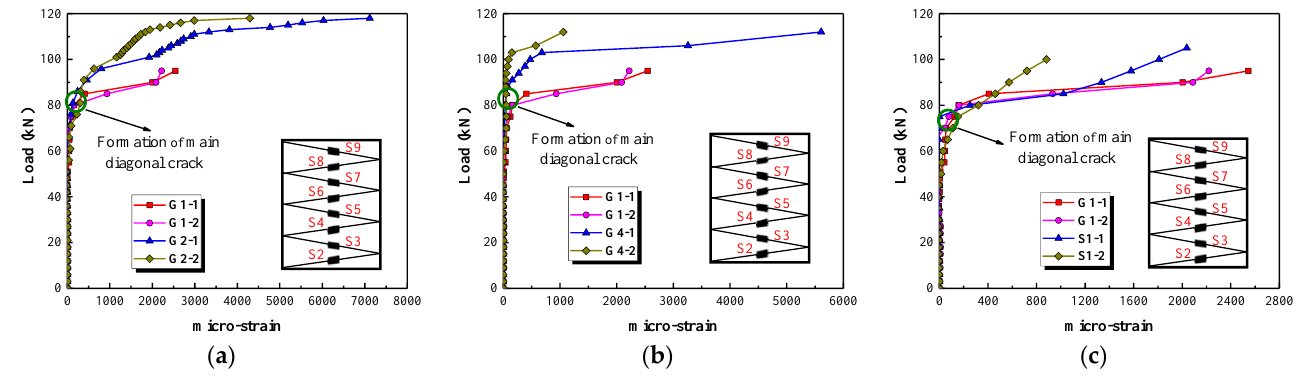
Figure 18. The effect of three parameters on strain in the stirrups. ( a ) Stirrup reinforcement ratio; ( b ) Longitudinal reinforcement ratio; ( c ) Type of stirrups.